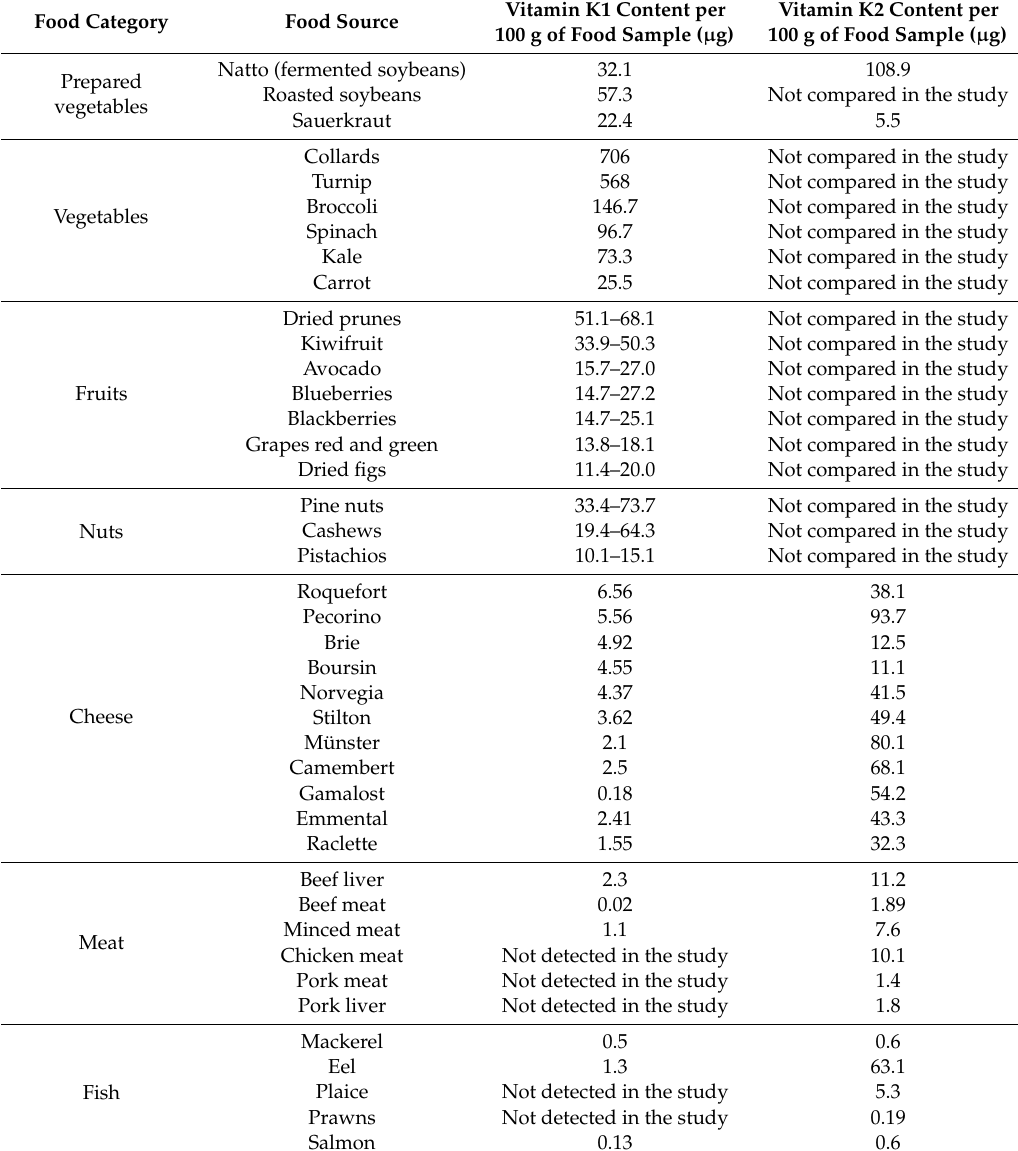
Table 1. Vitamin K1 and K2 content in various food